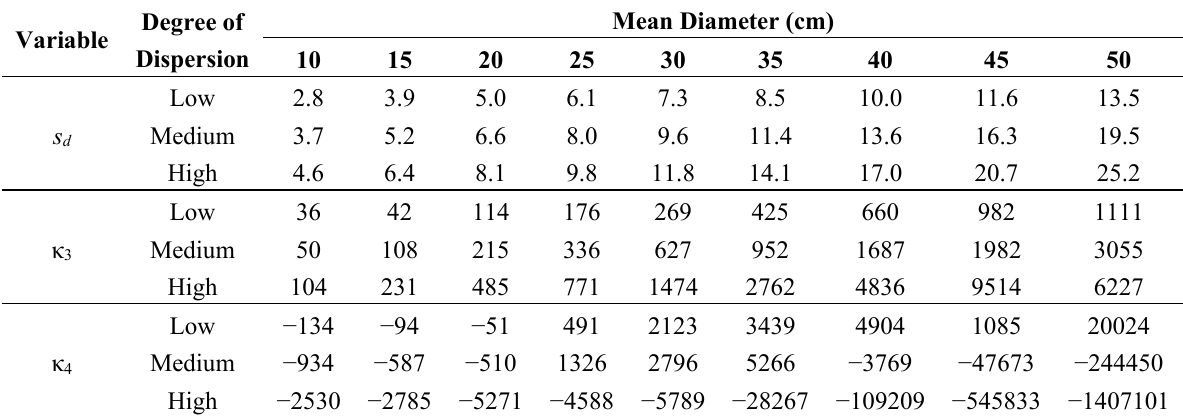
Table 4. Input variables for diameter distribution